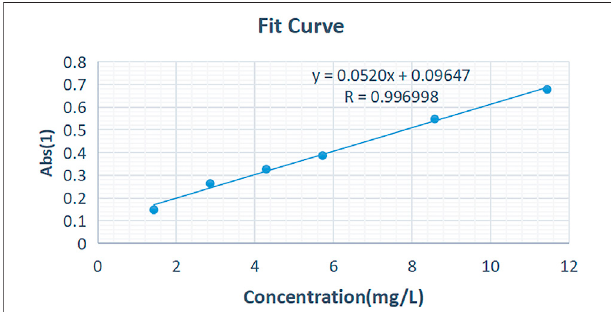
FIGURE 5 | Concentration-absorbance standard curve of kaempferol solution.